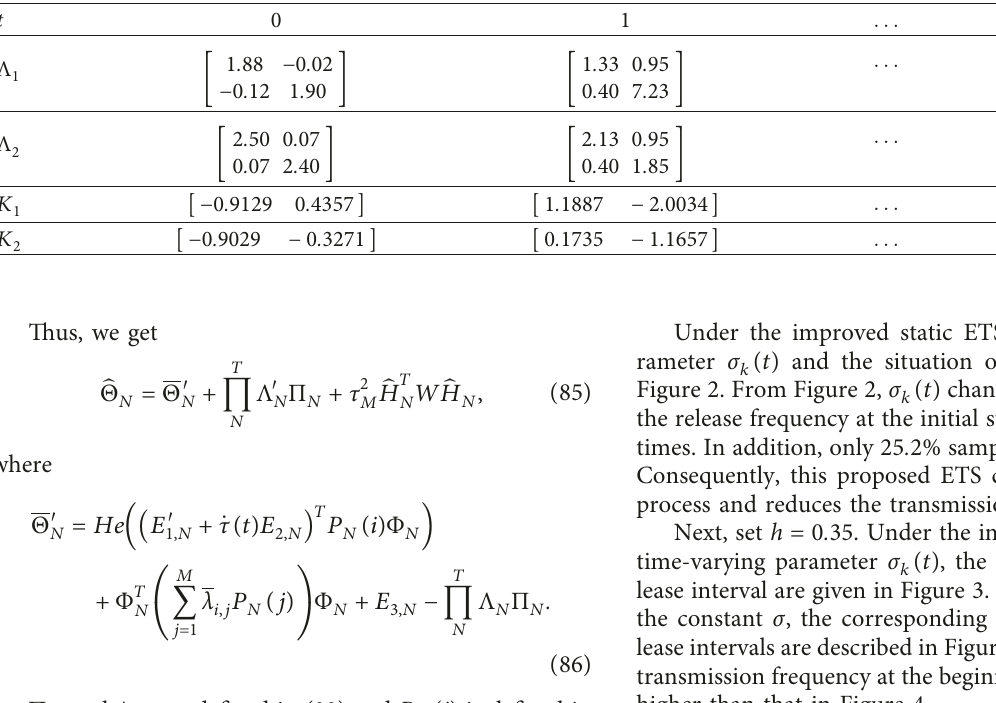
and K and trigger matrices Λ 1 2